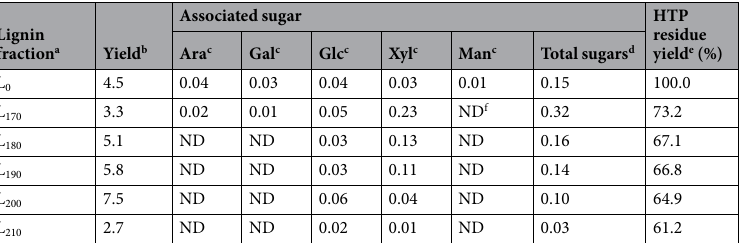
Table 1. HTP residue yields and contents of associated carbohydrates of the lignin fractions obtained from Eucalyptus . a L 170 , L 180 , L 190 , L 200 , and L 210 represent the lignin fractions obtained from the hydrothermal pretreated Eucalyptus at 170, 180, 190, 200, and 210 °C for 0.5 h followed by alkaline pretreatment with 2% NaOH aqueous solution at 80 °C for 2 h, respectively. L 0 was fractionated from the untreated Eucalyptus directly under the same alkaline pretreatment condition. b Based on the initial weight of the raw materials (%, w/w). c Abbreviations: Ara, arabinose; Gal, galactose; Glc, glucose; Xyl, xylose; Man, mannose. d Based on the dry mass of lignin (%, w/w). e Yield of the hydrothermal pretreatment residue. The HTP residue yield was defined as g of hydrothermal pretreatment residue per 100 g of raw material on a dry weight basis. f ND, not